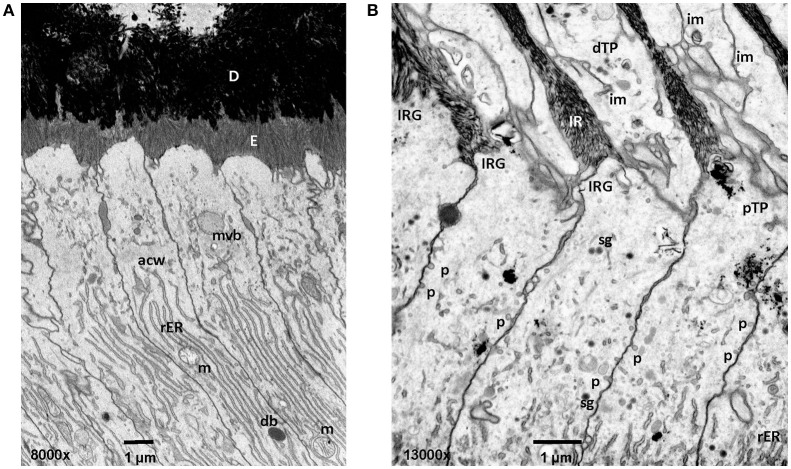
Early and mid secretory stage ameloblasts in mandibular mouse incisors. All procedures involving animals were reviewed and approved by the IACUC committee at the University of Michigan and all relevant guidelines were followed. Handling of animals and tissues was followed according to protocols described earlier (Smith et al., 2016). (A) The Tomes' processes are not fully developed in early secretory stage ameloblasts. Enamel crystallite ribbons in the initial interrod layer are oriented perpendicular to dentin and the apical ameloblast membrane. (B) In mid secretory ameloblasts pinocytotic vesicles are observed along the non-secreting surface of the Tomes' process and laterally between adjacent ameloblasts below the level of the apical junctional complex. In the distal portion of the Tomes process membrane infoldings form a complex network and are in close relationship to vesicles. D, dentin; E, enamel; mvb, multivesicular body; acw, apical cell web; rER, rough endoplasmic reticulum; m, mitochondria; db, dense body (lysosome); im, membrane infolding; dTP, distal portion of Tomes' process; IRG, interrod growth site; pTP, proximal portion of Tomes' process; sg, secretory granule; p, pinocytotic vesicle.